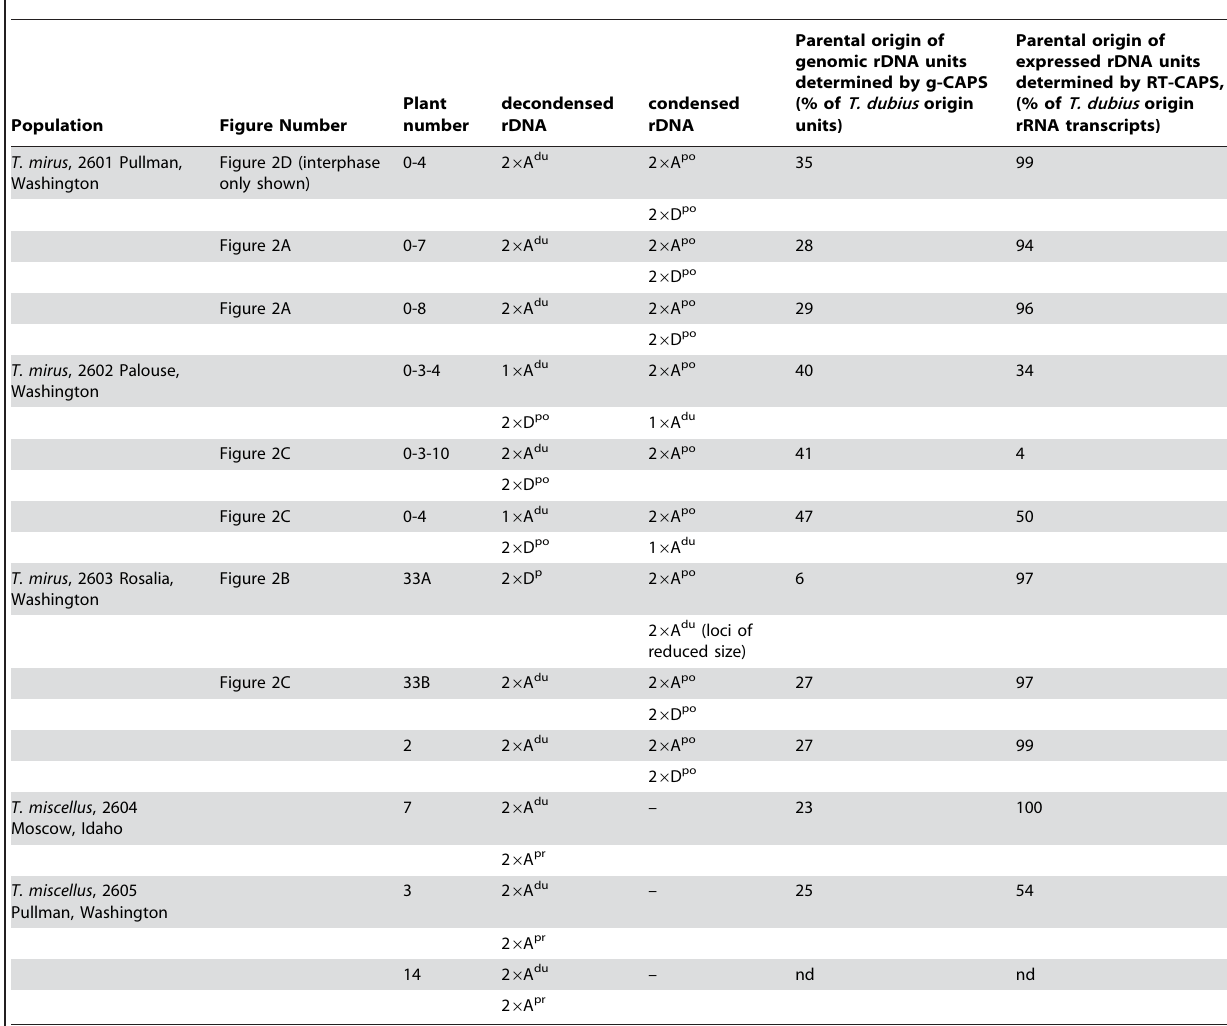
Table 3. Genomic origin of decondensed rDNA compared with previously published data from Kovarik et al. [22] and Matyasek et al. [23] using genomic–cleaved amplified polymorphic sequence (g-CAP) and reverse transcription-cleaved amplified polymorphic sequence (RT-CAP) to determine the genomic origin of rDNA sequences in the genome and the cDNA,